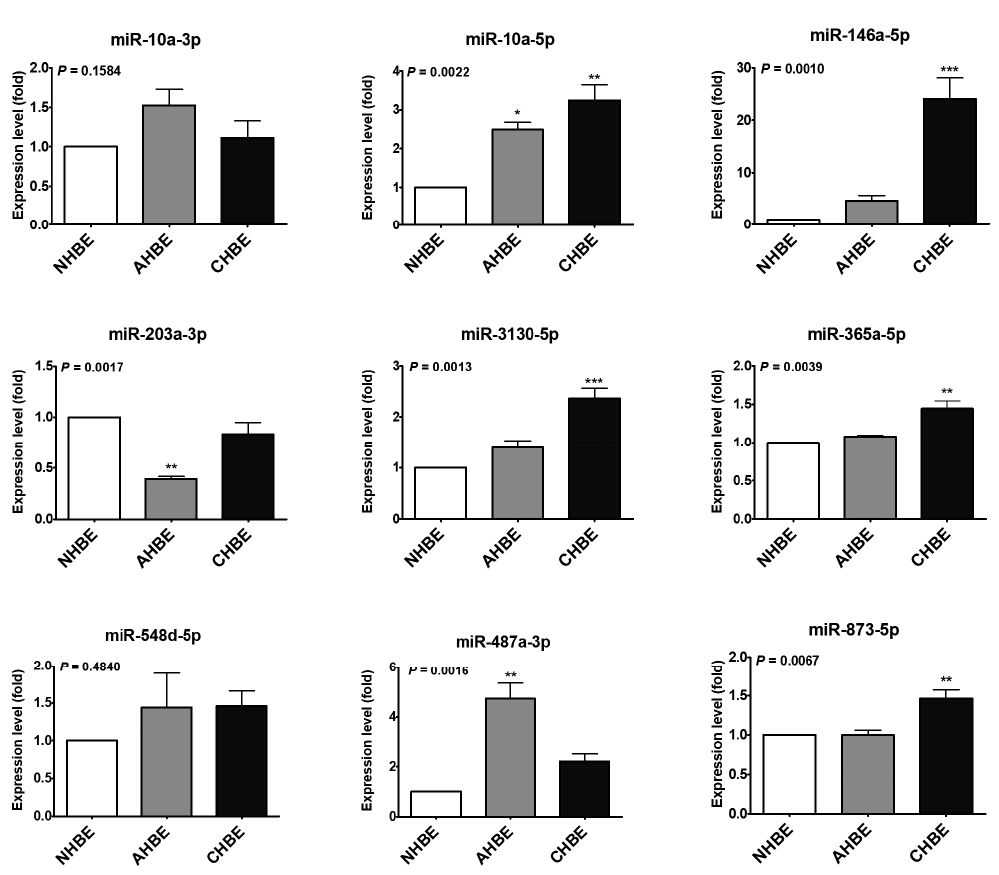
* The primary human bronchial epithelial cells (HBEs) used for next-generation sequencing (NGS) included HBE from an asthmatic patient (AHBE), HBE from a patient with chronic obstructive pulmonary disease (CHBE), and HBEs from normal subjects (NHBEs). Because of different timing of the study, different NHBEs were used for the NGS analyses that comparing the expression levels of microRNAs between AHBE and NHBE and between CHBE and NHBE. rpm, read per million.